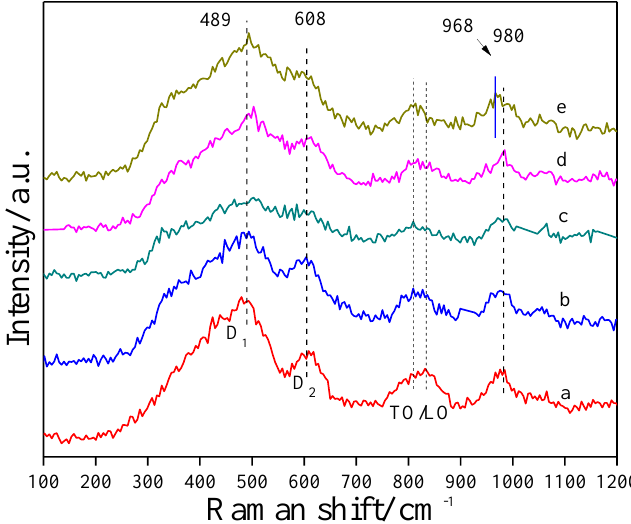
Figure 3. Raman spectra of calcined PtSn/DMSN catalysts with different ratios of Pt and Sn: (a) Pt/DMSN, (b) Pt 1 Sn 1 /DMSN, (c) Pt 1 Sn 2 /DMSN, (d) Pt 1 Sn 3 /DMSN, (e) Pt 1 Sn 4 /DMSN.